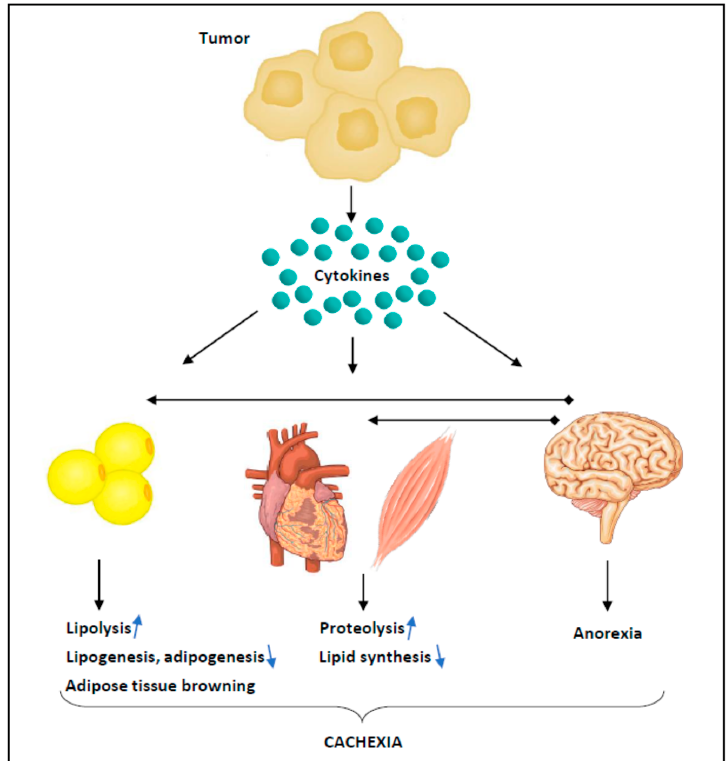
Figure 1. Mechanisms involved in cancer cachexia. Tumour-derived catabolic factors such as pro-inflammatory cytokines act on target tissues to elicit excess catabolism. Alteration of the central nervous system results in reduced food intake and increased catabolic neural outputs. Proteolysis is induced in skeletal and cardiac muscles through up-regulation of the ubiquitin-proteasome system and autophagy. Reduced protein synthesis has also been reported. Loss of adipose tissue results from increased lipolysis, decreased lipogenesis and adipogenesis and white adipose tissue browning.